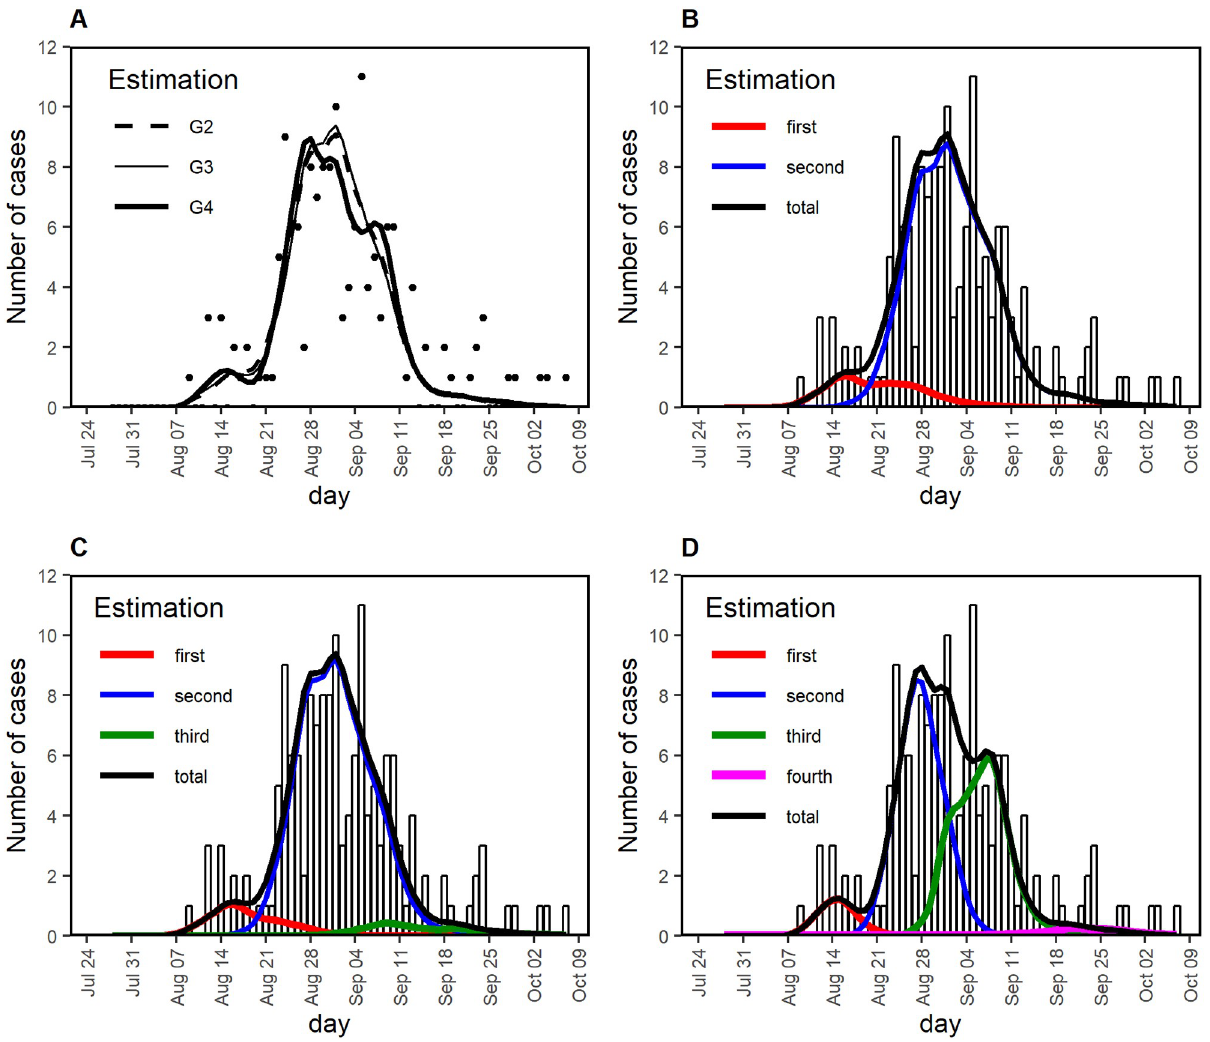
Fig 3. Comparison between observed and estimated epidemic curves of the 2014 dengue outbreak in Tokyo. (A) Total number of cases with time of illness onset. Black dots show the observed number of cases; lines are derived from mathematical models with different numbers of assumed generations of infection, G2, G3, and G4, representing a total number of generations of 2, 3, and 4, excluding generation zero. (B–D) Comparison between observed and estimated cases by different numbers of assumed generations of infection, G2, G3, and G4, corresponding to panels B, C, and D, respectively. The observed number of cases is shown as bars. Red, blue, green, and magenta lines depict the estimated cases generated by first, second, third, fourth generation cases, respectively. Black line represents the estimated total number of cases.